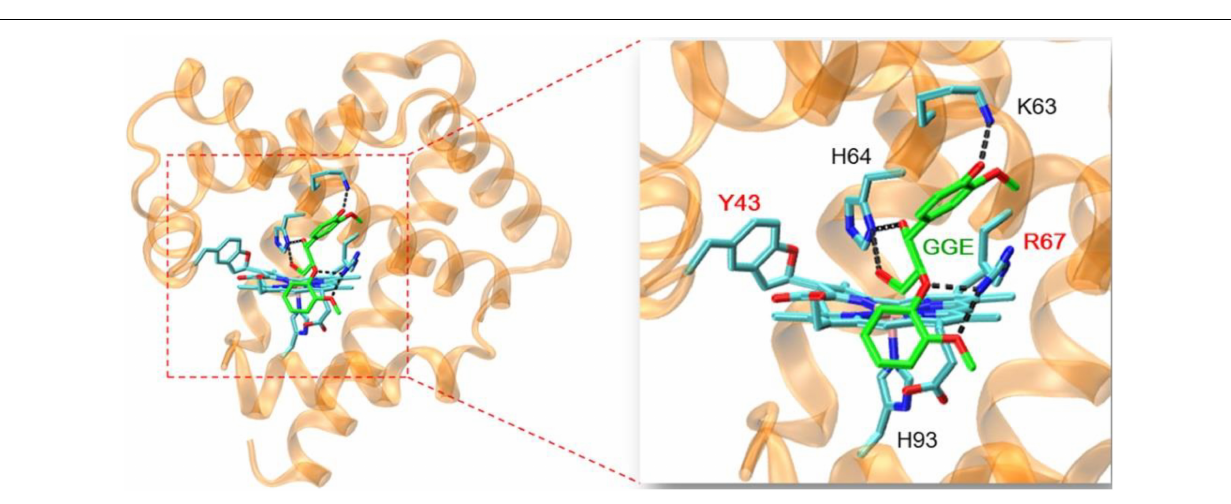
FIGURE 6 | Molecular docking structure of GGE binding to F43Y/F46R Mb with the lowest binding energy. The structure of GGE is shown in green, and the H-bonding interactions between GGE and protein residues are indicated by dashed